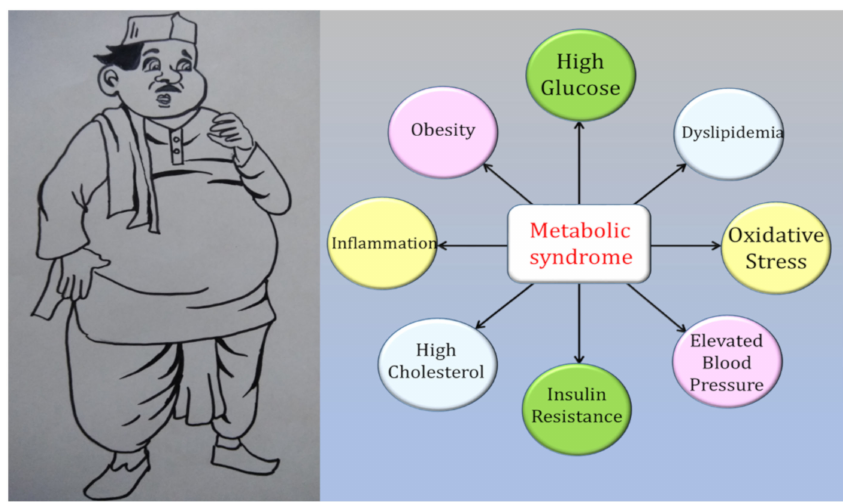
Figure 1. Schematic representation of the risk factors for metabolic